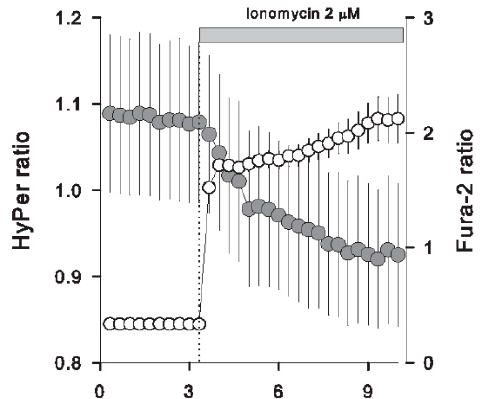
Figure 4. Ionomycin induces a diminishment in the HyPer signal. Caco-2 cells loaded with Fura-2 dye (open circles, 21 cells from three independent experiments) and another set of Caco-2 cells expressing HyPer (grey circles, 11 cells from three independent experiments) were exposed to 2 µ M ionomycin at the time indicated by the dotted line and grey bar on the plot. Data correspond to the average ± SE.